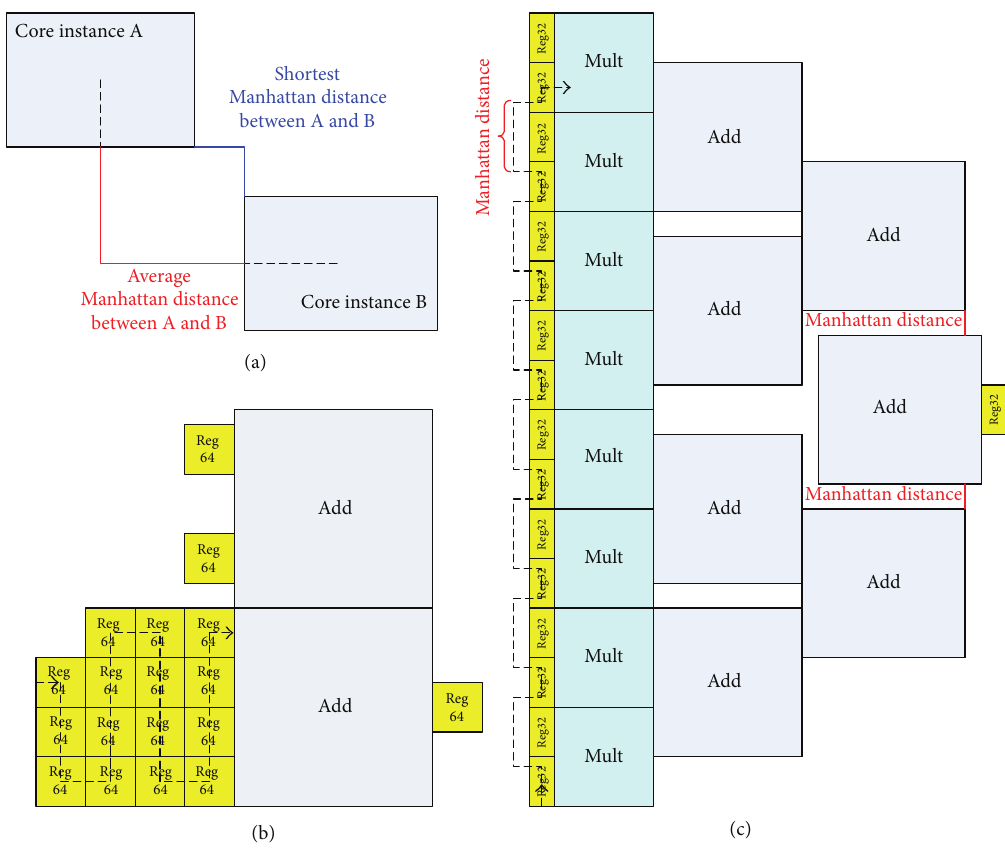
Figure 6: Placement estimation of core instances for the following: (a) generic case, (b) DPFP summation, and (c) 8-tap FIR